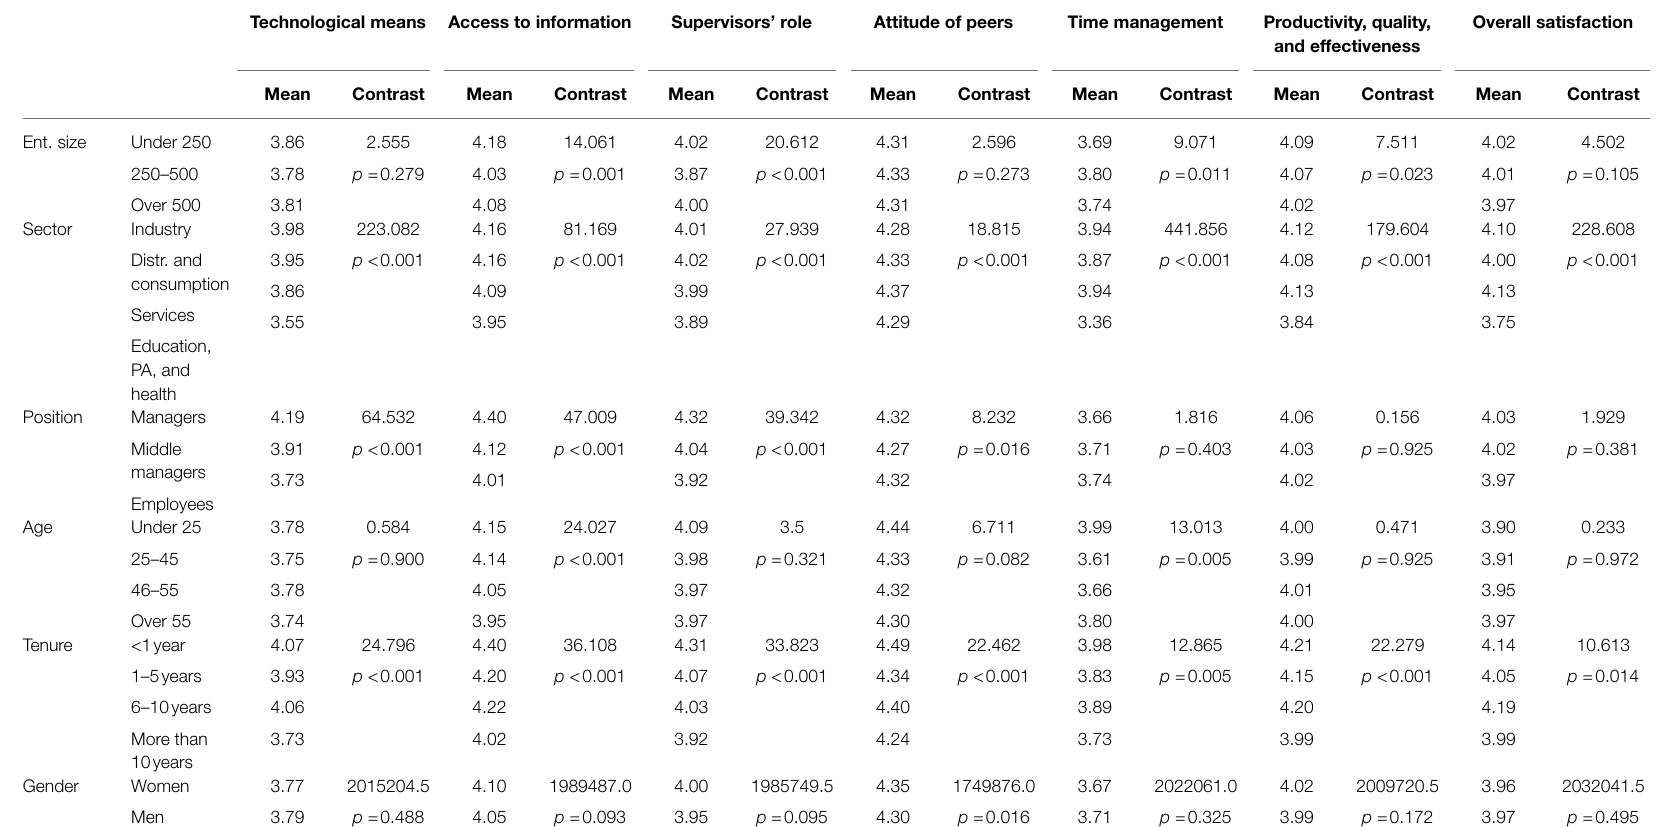
TABLE 5 | Comparisons of the scores on teleworking by sociodemographic variables (teleworkers subsample). Technological means Access to information Supervisors’ role Attitude of